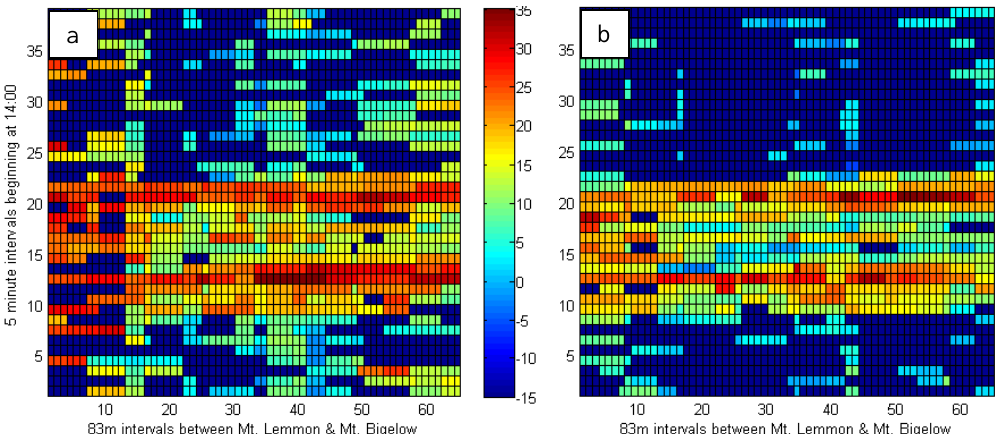
Fig. 14. Radar measured reflection in dBz, at radar elevation of (a) 0.88 ◦ and (b) 1.28 ◦ , time is vertical scale in units of 5min intervals beginning at 14:00. The left edge is Mt. Lemmon, and right hand edge is Mt. Bigelow. The 5.4km path between them is divided into 65 equal intervals. The units of the color scale shown in the center are dBz.